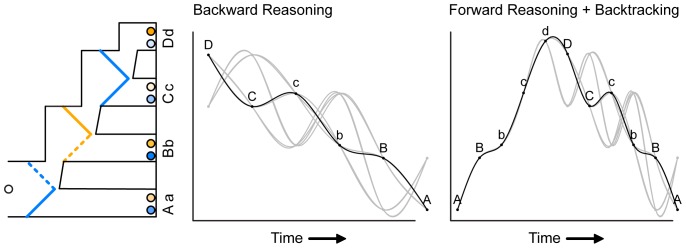
An example second-order Marble Drop game (left panel), and associated fixation sequences predicted on the basis of backward reasoning (middle panel) and forward reasoning plus backtracking (right panel).The fixation sequences represented by the black lines are annotated for AOI (A – D; a – d), and those represented by the grey lines are not. Player 1′s payoffs are labeled with uppercase A, B, C, and D. Player 2′s payoffs are labeled with lowercase a, b, c, and d. The sequences are depicted on “eye movement paths” for illustrative purposes.